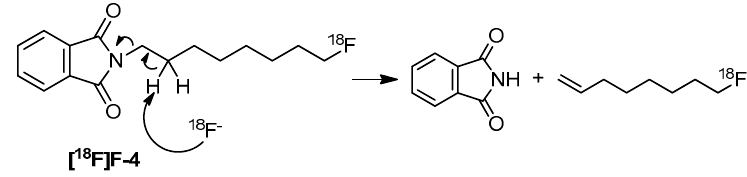
Scheme 2. Proposed eliminated product derived from [ 18 F] 4 .